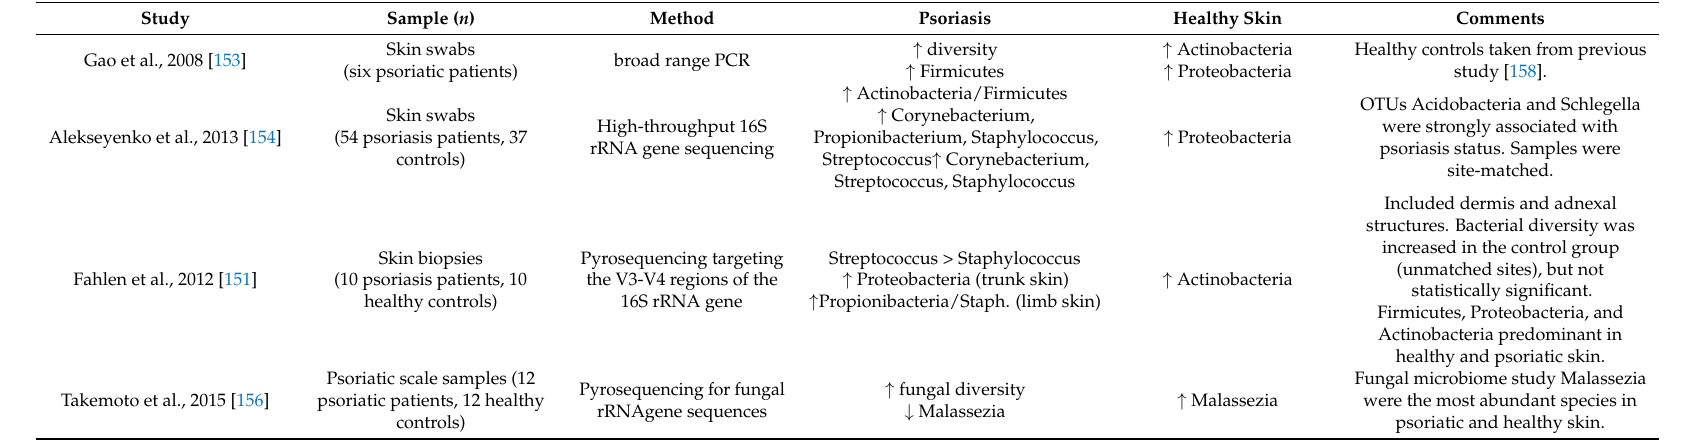
Table 2. Psoriasis microbiome. ↑ increased. > higher